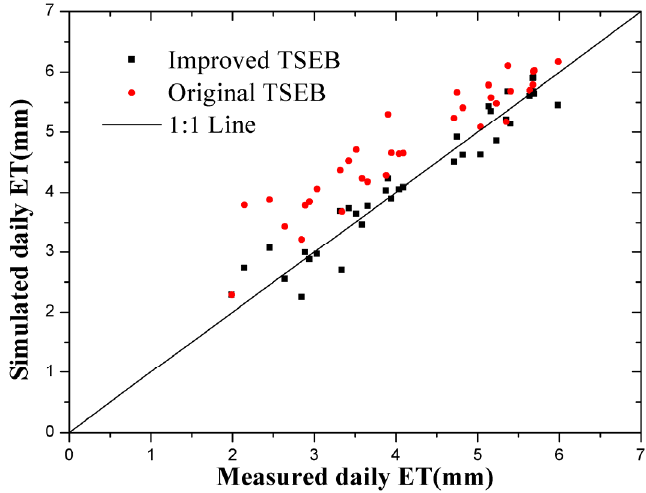
Figure 8. Comparison of the daily ET derived from the improved and original TSEB with EC tower-based measurements.